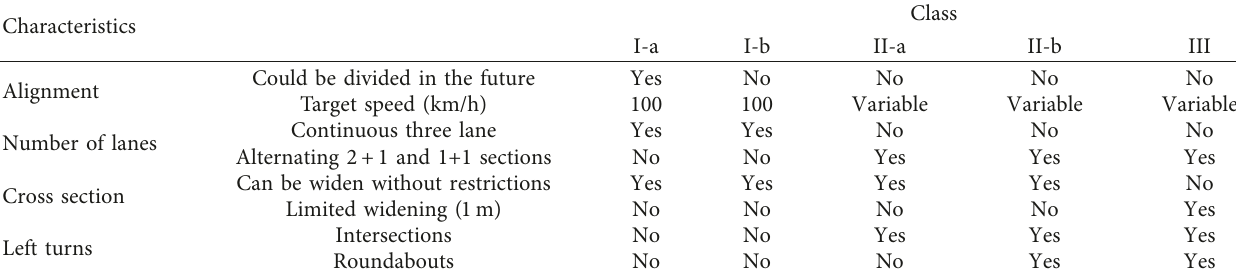
Table 9: Proposed classification of 2+1